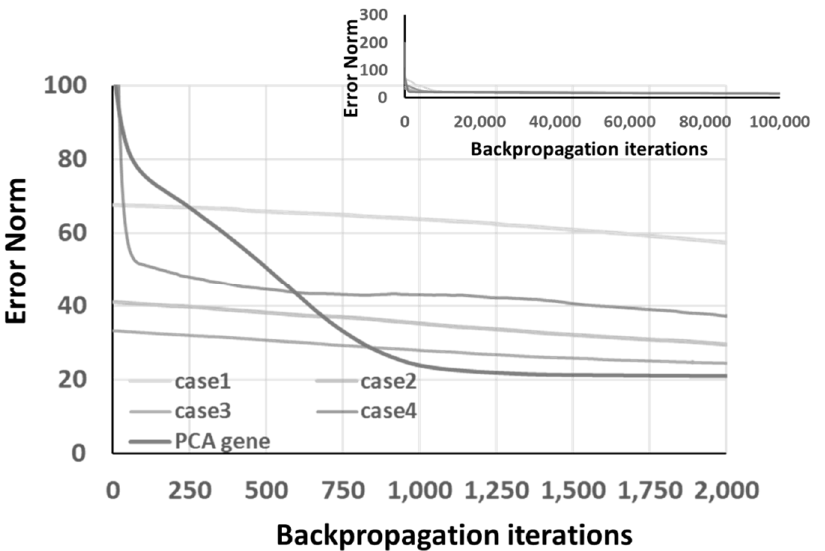
Figure 20. The convergence of 4 GA “progressing” optimized chromosomes and PCA gene under RNN architecture by the same initial 2000 GA generation in Table 5.